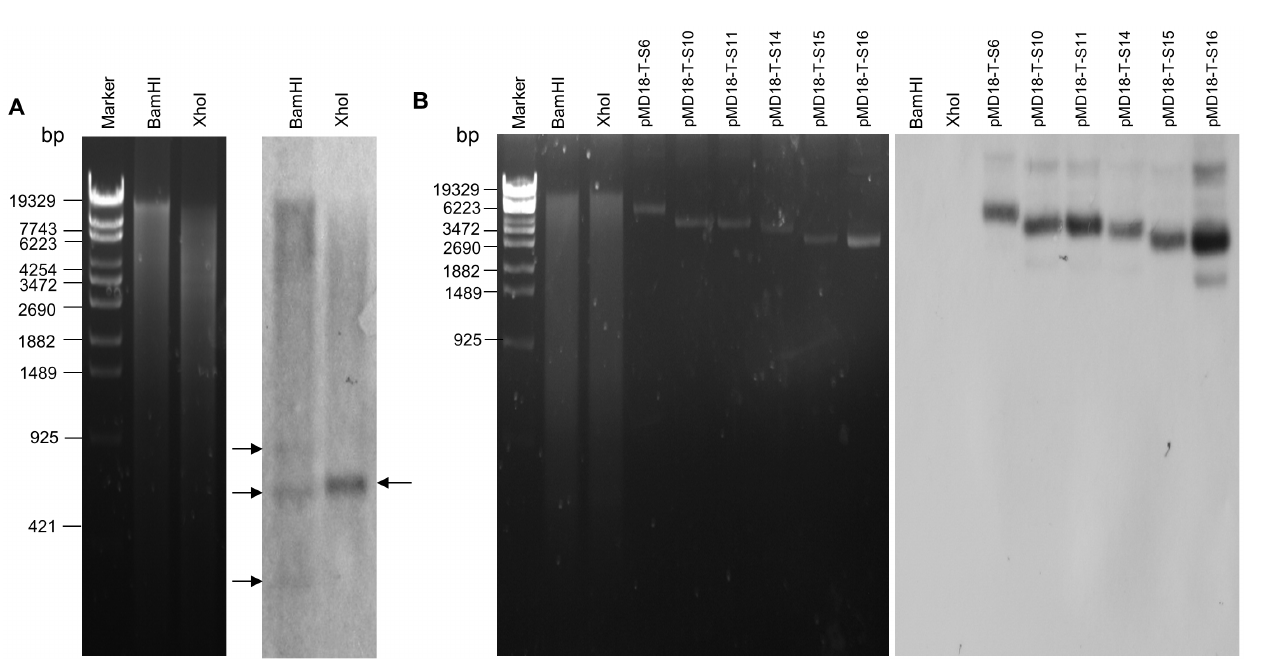
Figure 6. Southern blot analysis of genomic DNA of S. exigua larvae. A. Electrophoresis (left) and southern blot (right) of restriction endonuclease- digested genomic DNA of S. exigua larvae, detected by pheromone-binding protein 3 (PBP3) probe. Marker, phage l DNA digested with Eco T14 I. XhoI, Xho I-digested genomic DNA of S. exigua larvae (2 m g). BamHI, Bam HI-digested genomic DNA of S. exigua larvae (2 m g). The arrows indicate hybridization bands in genomic DNA of S. exigua larvae. B. Electrophoresis (left) and southern blot (right) of restriction endonuclease-digested genomic DNA of S. exigua larvae, detected by probe mixture of six DpCPV-MC dsRNA segments (S6, S10, S11, S14, S15 and S16). The six plasmids containing full-length sequence of six segments was used as positive control. Marker, phage l DNA digested with Eco T14 I. XhoI, Xho I-digested genomic DNA of S. exigua larvae (2 m g). BamHI, Bam HI-digested genomic DNA of S. exigua larvae (2 m g). pMD18-T-S6, pMD18-T vector containing full-length sequence of S6 (2 ng). pMD18-T- S10, pMD18-T vector containing full-length sequence of S10 (2 ng). pMD18-T-S11, pMD18-T vector containing full-length sequence of S11 (2 ng). pMD18- T-S14, pMD18-T vector containing full-length sequence of S14 (2 ng). pMD18-T-S15, pMD18-T vector containing full-length sequence of S15 (2 ng). pMD18-T-S16, pMD18-T vector containing full-length sequence of S16 (2